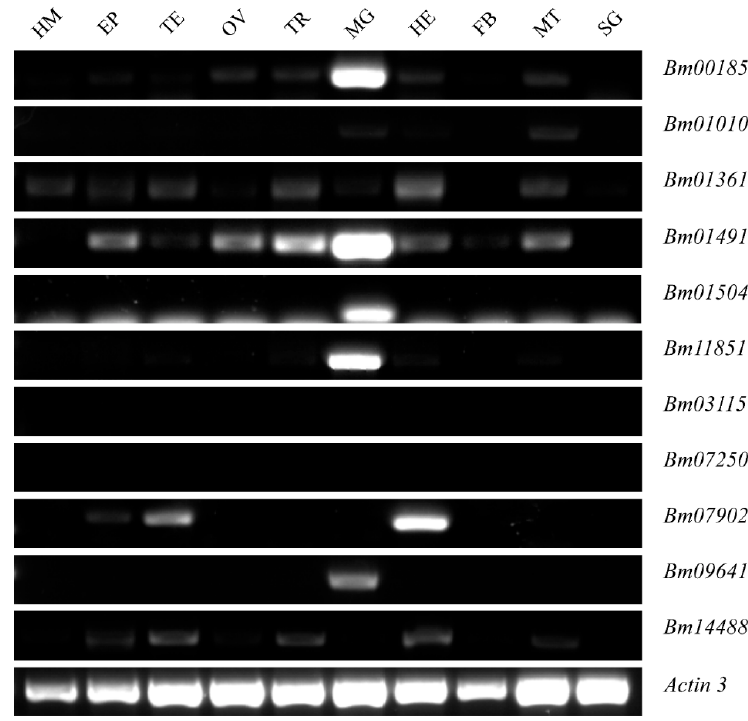
Figure 2. The expression levels of the 11 identified peritrophins in various tissues at 3rd day of the fifth instar larvae. Bm03115 , Bm07250 , Bm07902 , and Bm14488 were not detected in the